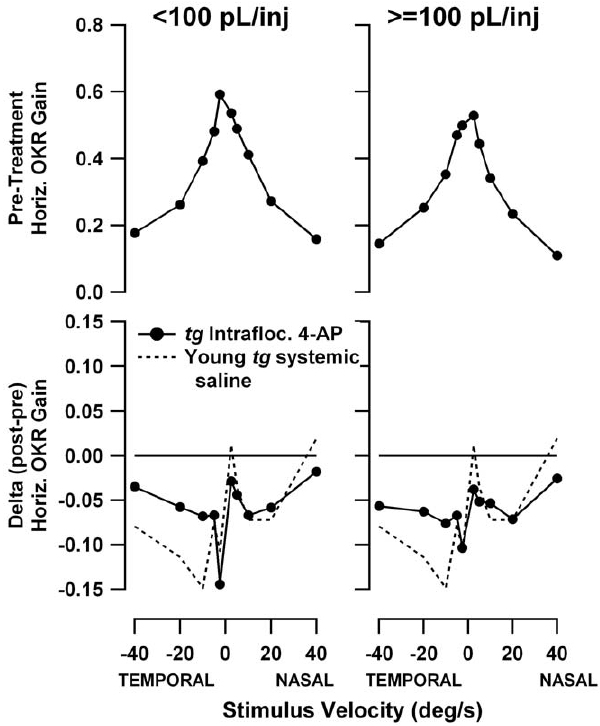
Figure 13. Effect of 4-AP on roll OKR speed tuning, following low-volume ( , 100 pL/injection, left panels) and high-volume ( . 100 pL/injection, right panels) intrafloccular injections. Format of graphs is identical to Figure 12, with dashed curves replicating the systemic saline curves for young tottering from Figure 7. There is little difference between the intrafloccular drug injection and systemic saline gain-change curves, nor any significant difference between low-volume and high-volume sessions, indicating the lack of any effect of 4-AP.